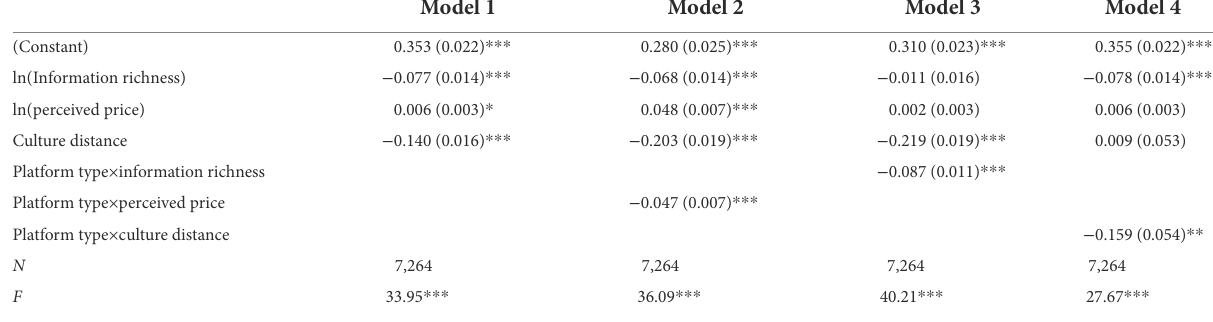
TABLE 3 Effects on user